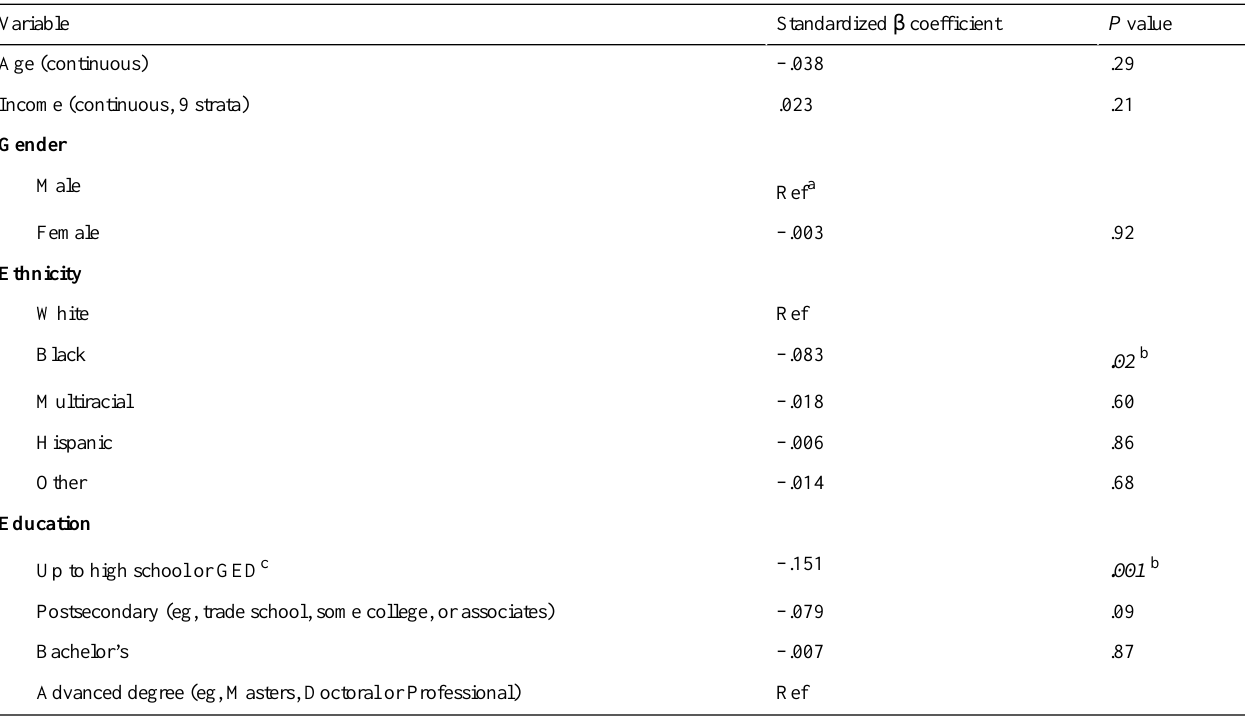
Table 3. Independent association between demographic characteristics and coronavirus-related eHealth literacy.